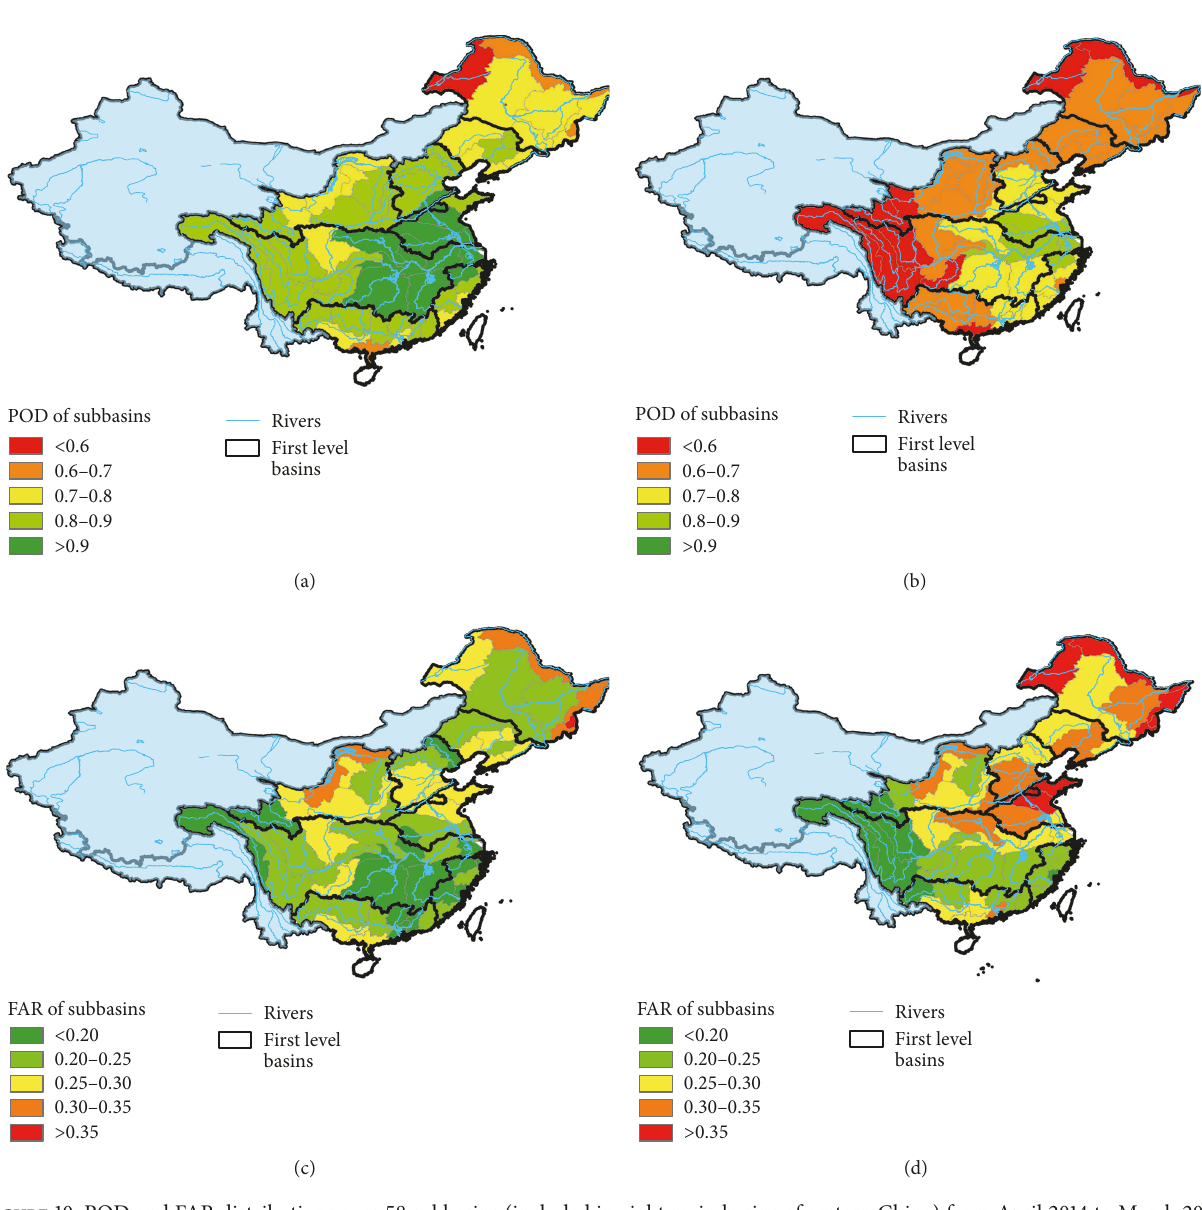
Figure 10: POD and FAR distributions over 58 subbasins (included in eight main basins of eastern China) from April 2014 to March 2016: POD for (a) GSMap-gauged and (b) IMERG; FAR for (c) GSMap-gauged and (d)